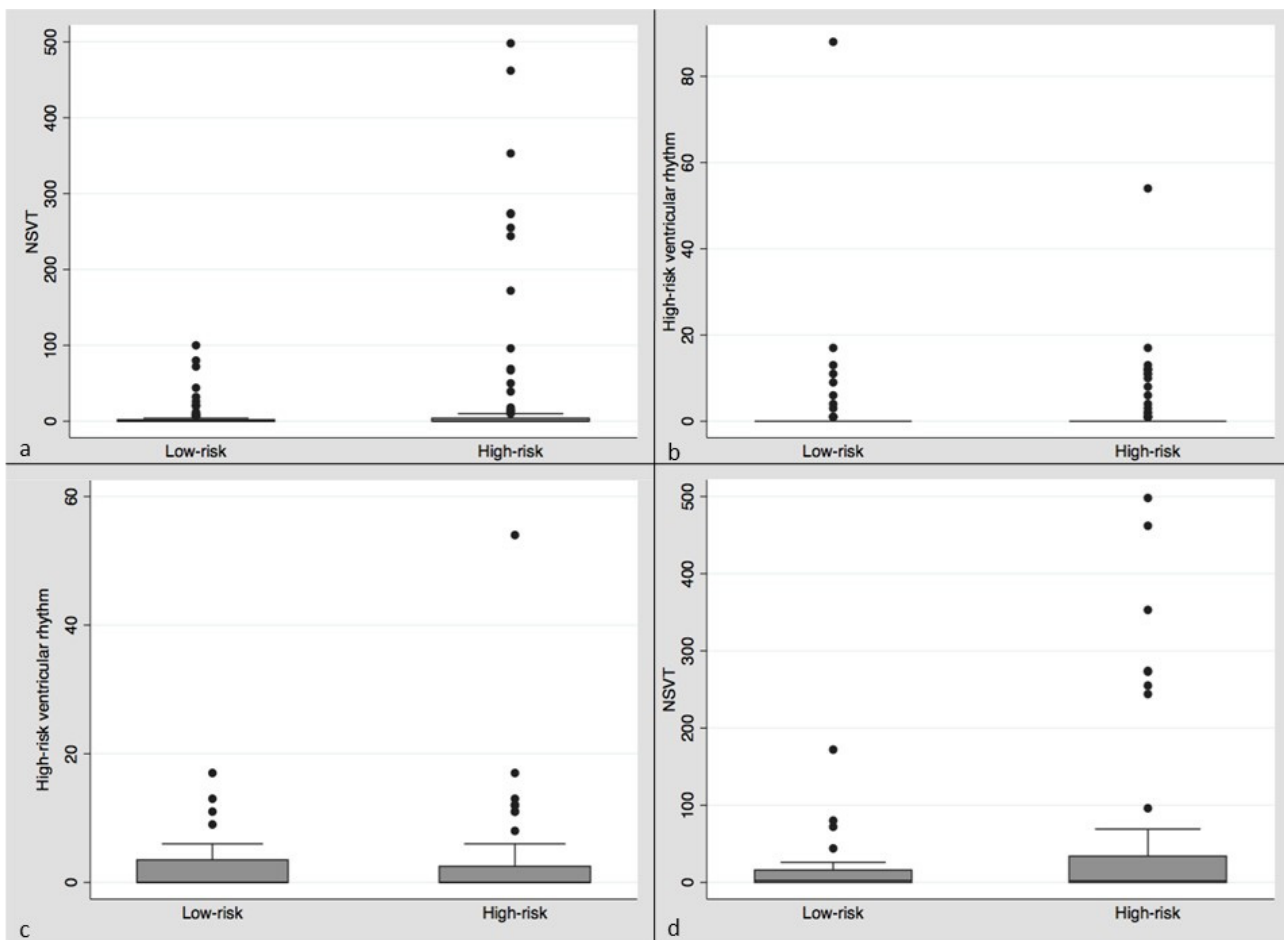
Table 2. Frequency of ventricular arrhythmias.